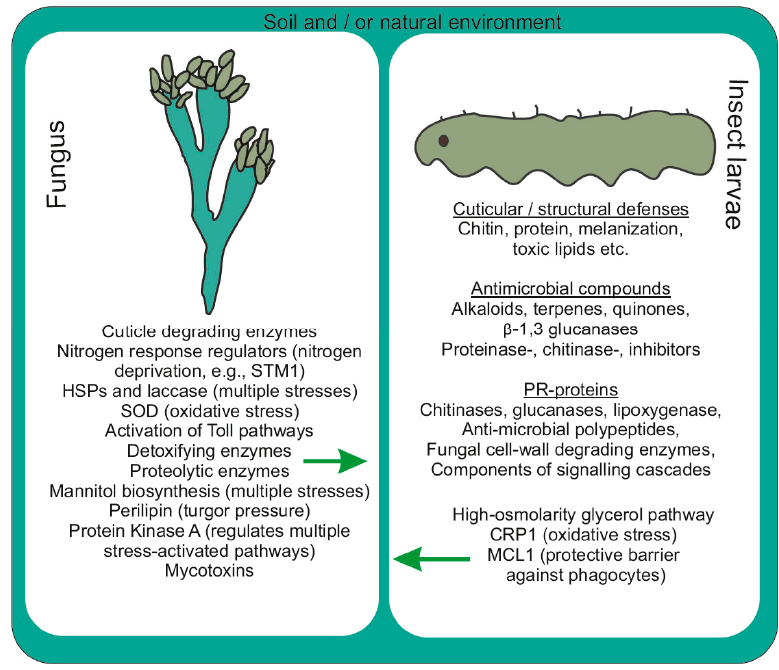
Figure 3. Defensive munitions observed during fungus-insect interactions (molecular interplay between two organisms) .